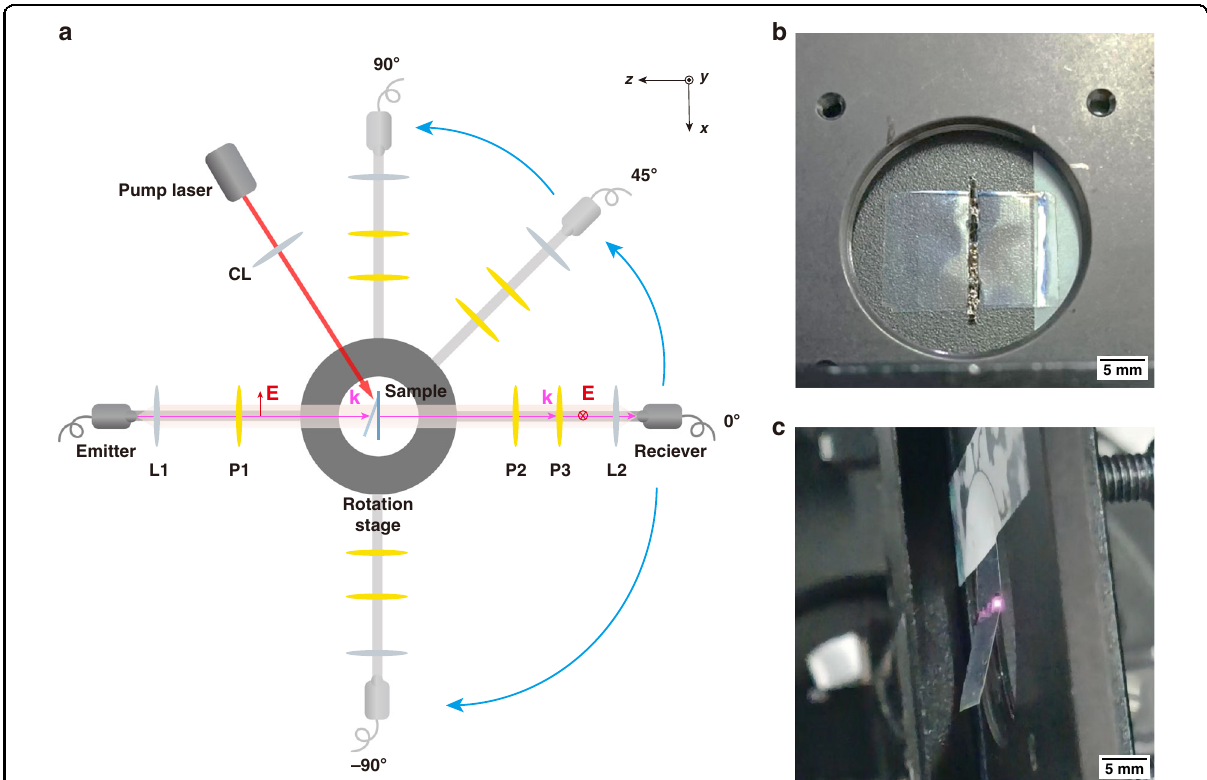
Fig. 6 The experiment setup for testing the infrared regulation of the LCE metasurface. a The schematic of the measurement optical system. L: Lens, CL: Cylindrical lens, and P: Polarizer. The de fl ected wave was detected at an angle resolution of 5° by rotating the rotation stage. b The sample holder. c the de fl ection of the LCE sample when 400 mW infrared light was focused on the